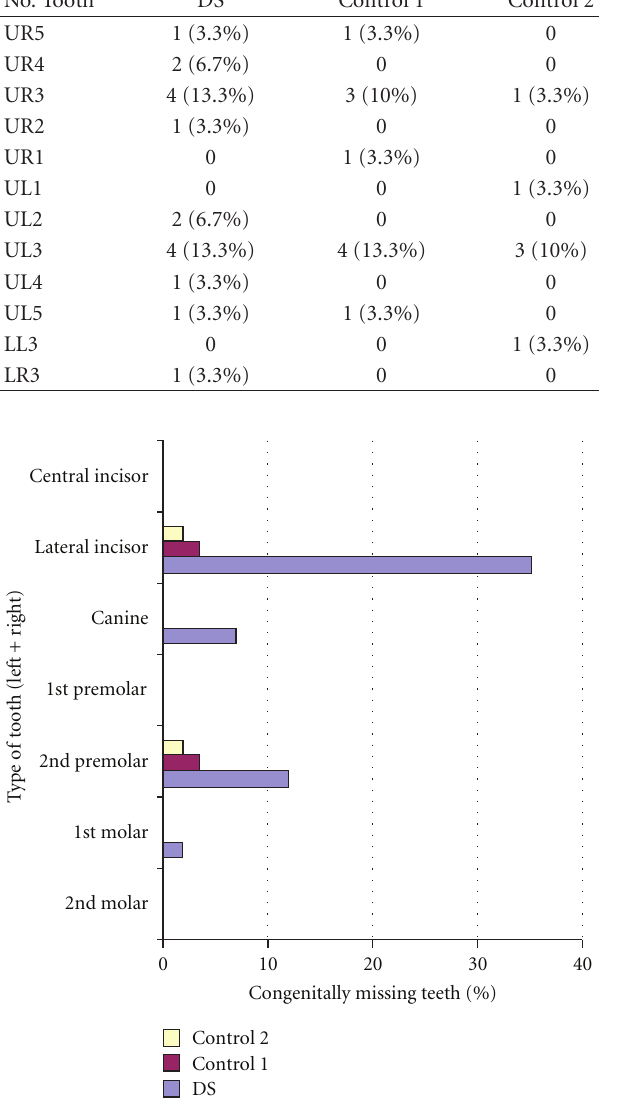
Figure 2: Comparison of missing maxillary teeth between the three groups.